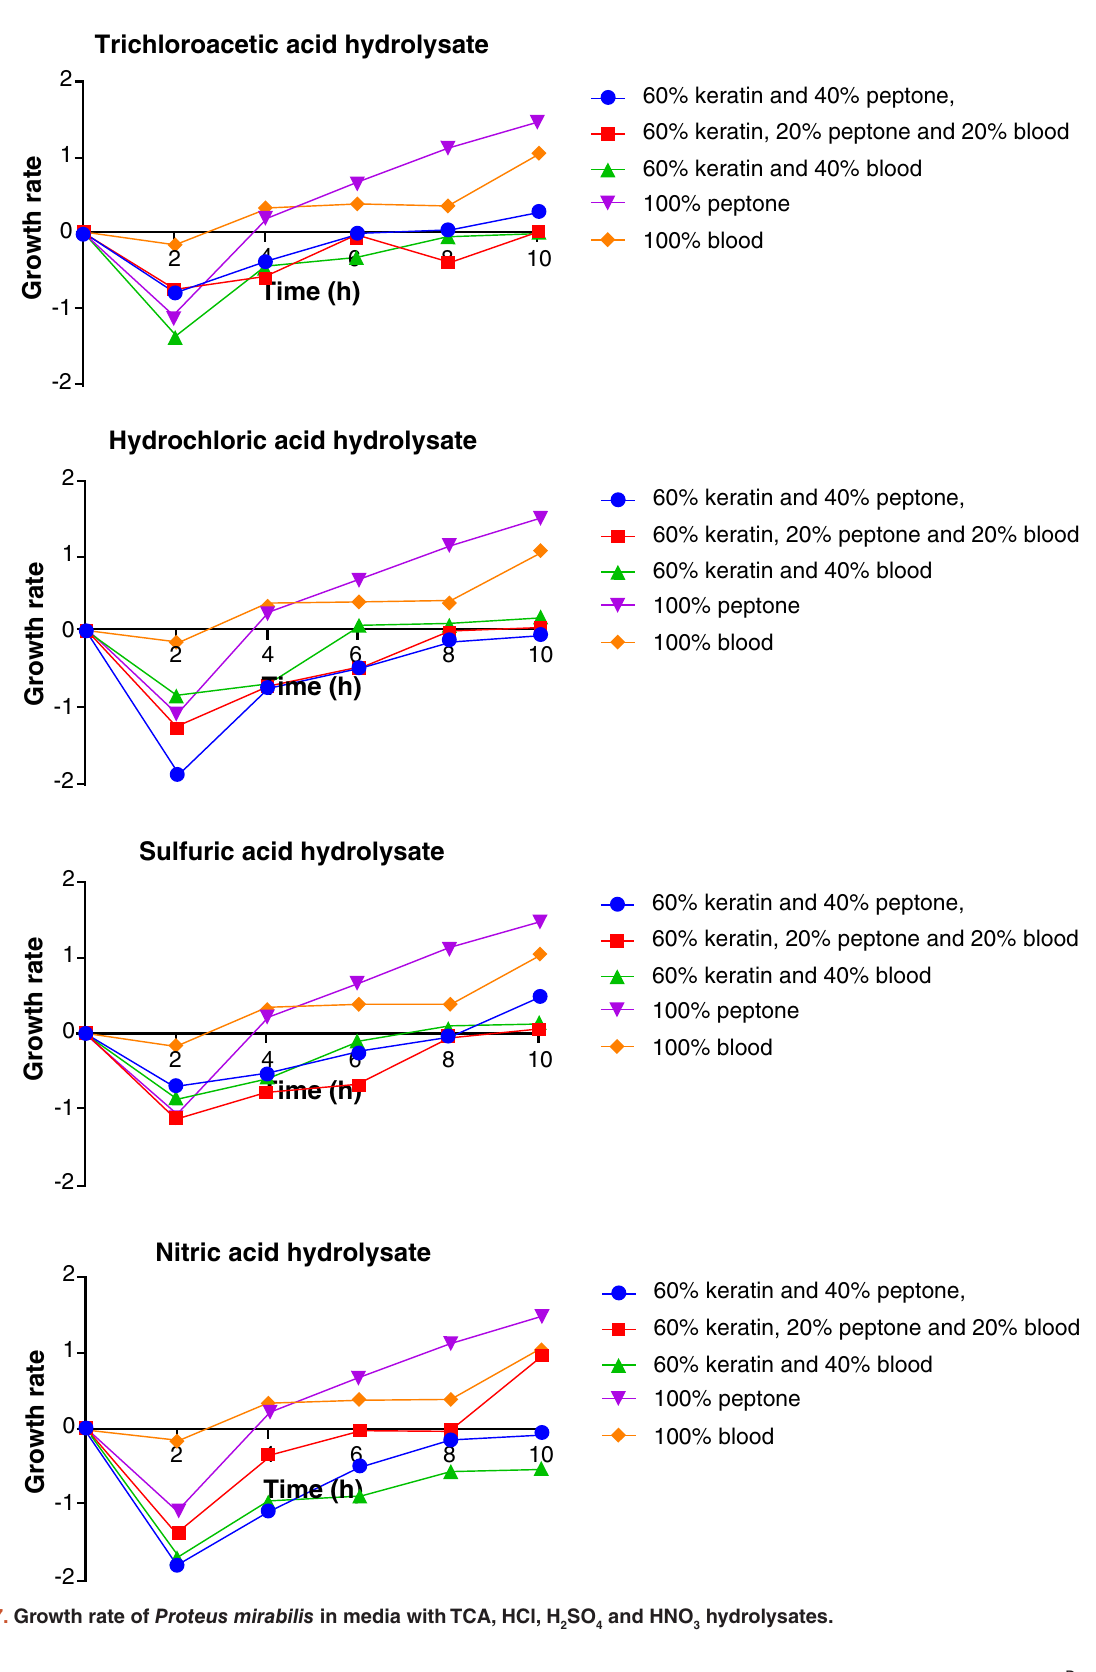
SO and HNO 2 4 3